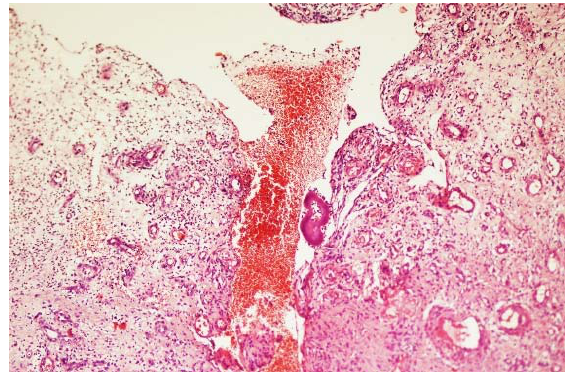
Figure 12. Photomicrograph showing A. madurae grains within the lumen of the intact blood vessel (H&E X 200).